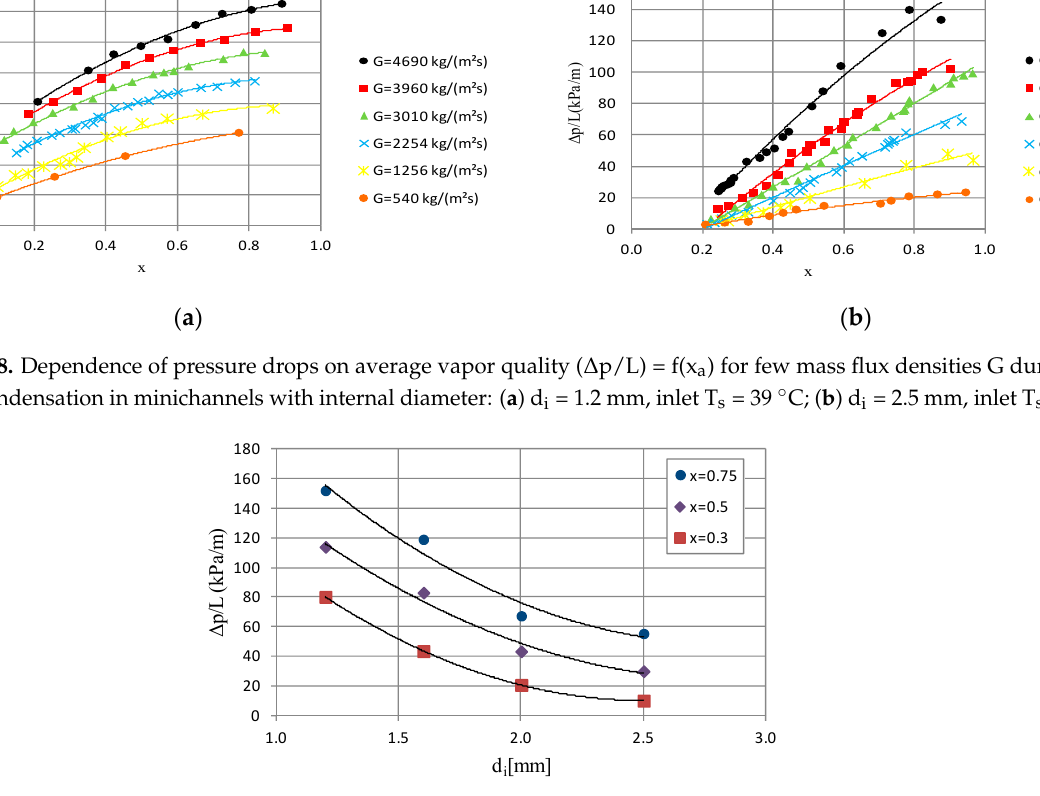
Figure 10. Dependence of pressure drops on mass flux density G for minchannels with internal diameter d i = 2.5, 2.0, 1.6 and 1.2 mm (x ≈ 0.5; T s = 39 °C). Figure 11. Dependence of heat transfer coefficient on mass flux density G for minchannels with internal diameter: d i = 2.5, 2.0, 1.6 and 1.2 mm (x ≈ 0.5; T s = 39 °C). Figure 12 shows a comparison of our own research results with the results of the research study conducted by Mikielewicz et al. [9]. Unfortunately, the scope of these studies is not identical, which causes discrepancies in the results. Figure 13 presents a comparison of our own research results on three low ‐ pressure refrigerant condensations